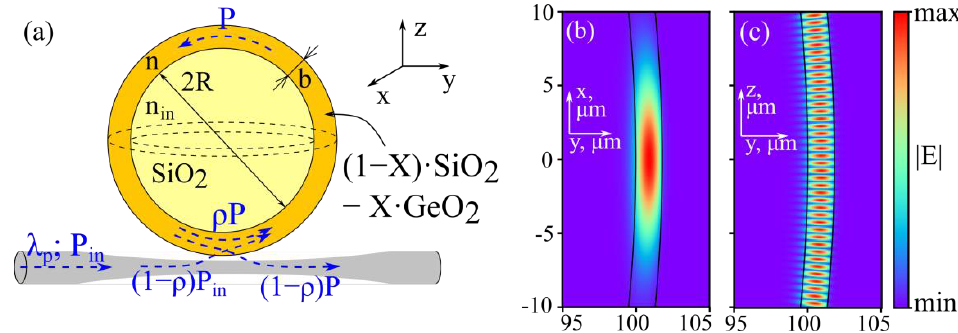
Figure 1. ( a ) Schematic of the proposed microresonator near the power coupling fiber taper; ( b , c ) Spatial distribution of the absolute value of electric field in the fundamental TE mode in the (x,y) and (y,z) planes, respectively; ( b , c ) share the same colormap.